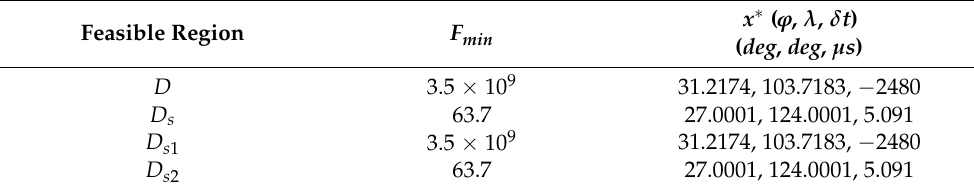
Table 6. Iterative process with initial value (97.4, 40.1, 0).